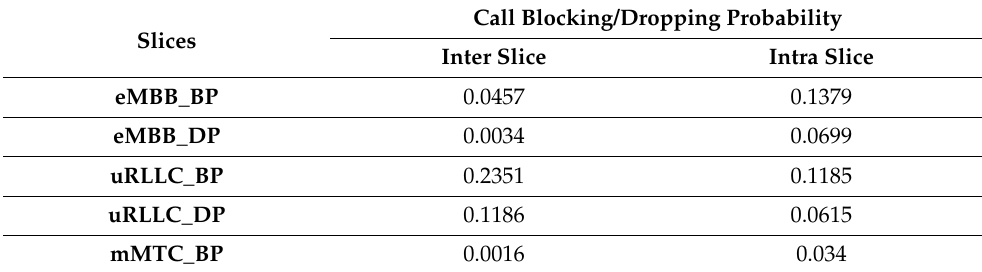
Table 1. Call Blocking/Dropping Probability on network Slices of